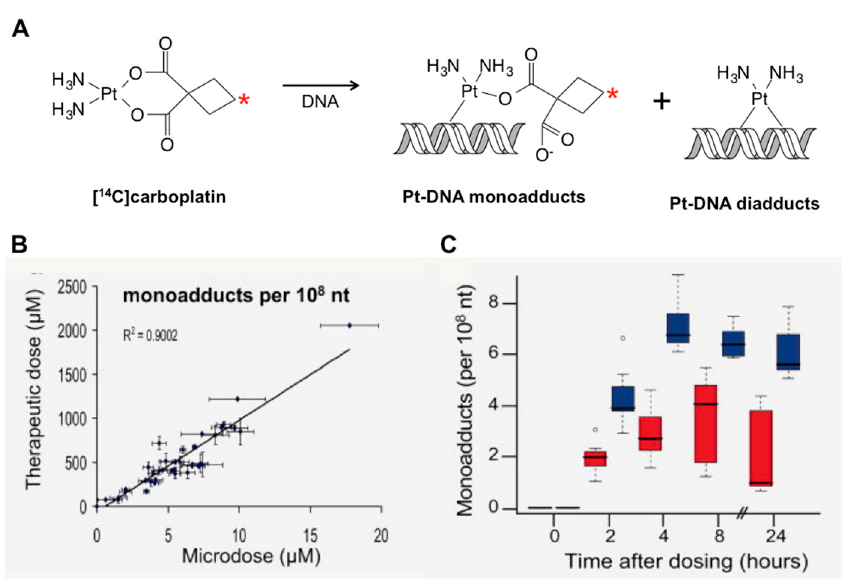
Figure 7. Correlation of microdose-induced [ 14 C]carboplatin-DNA adduct levels to therapeutic dose-induced adduct levels in cancer cell lines. ( A ) Diagram of carboplatin-DNA adduct formation. ( B ) Linear regression of microdose-induced versus therapeutic dose-induced carboplatin-DNA adducts. ( C ) Sensitive cell lines (blue) have significantly higher carboplatin-DNA adduct levels than resistant cancer cell lines (red).